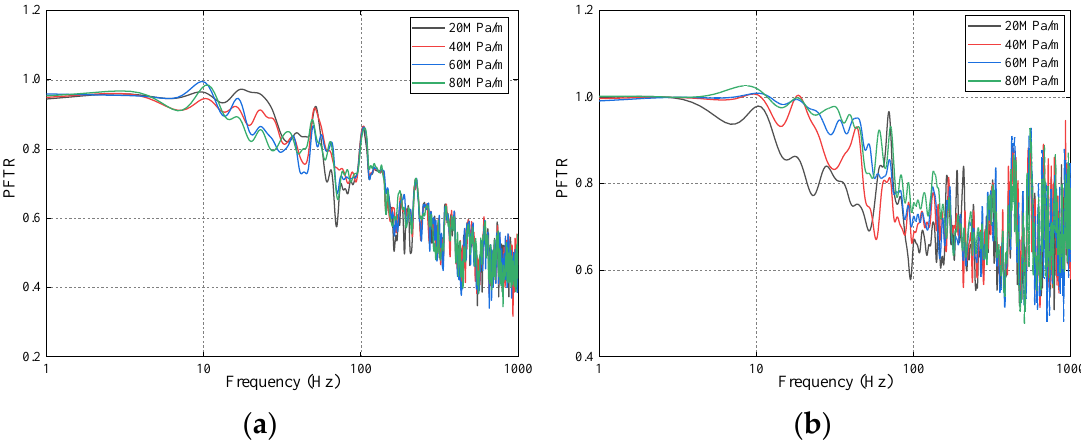
Figure 8. The PFTRs from ( a ) the rail to the slab track and ( b ) the slab track to the bridge.